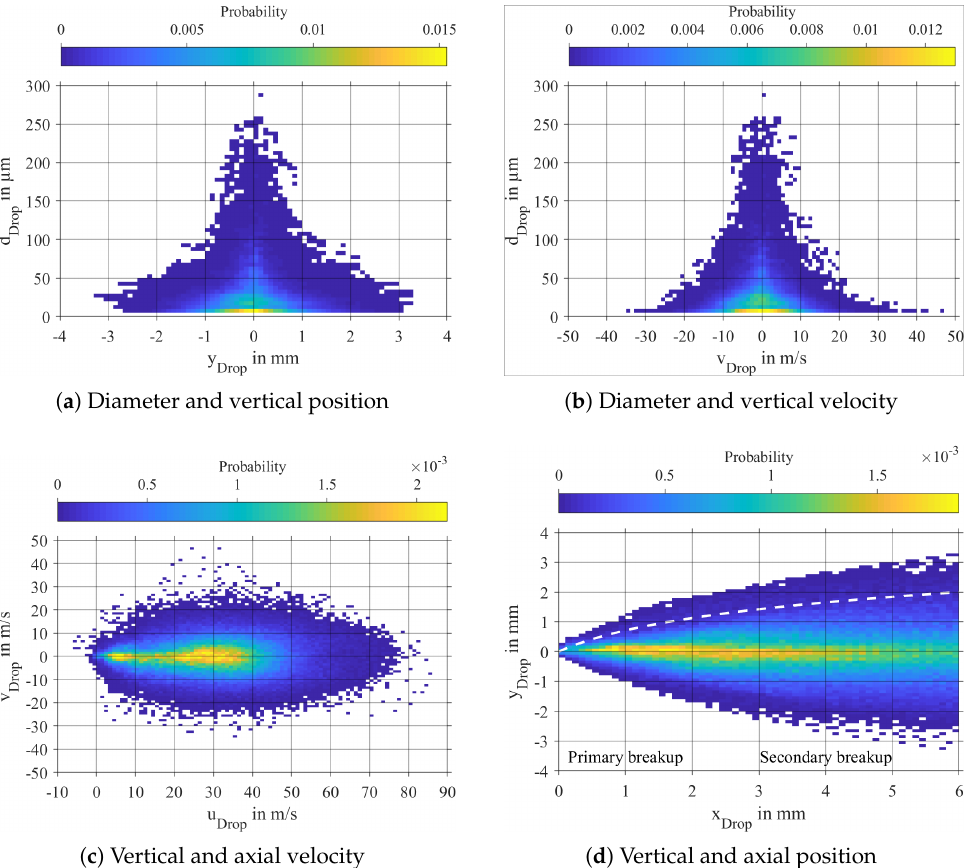
Figure 15. Interdependencies of spray quantities for p g = 5bar, u g = 70m/s, h a =